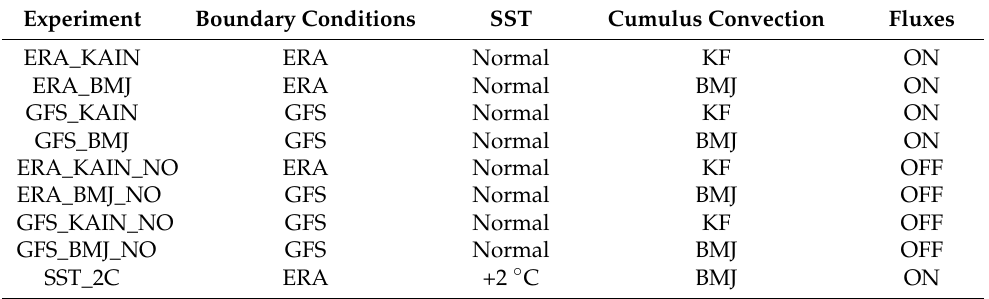
Table 2. Configuration of the experiments: nomenclature, boundary conditions, SST condition, cumulus parameterization scheme, and turbulent heat fluxes turn on or turn off.